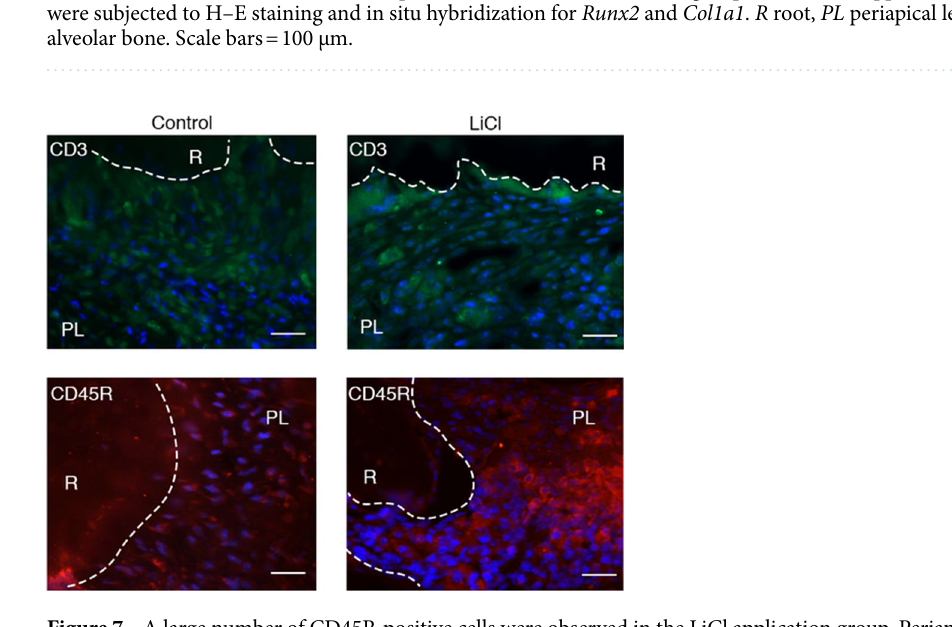
Figure 7. A large number of CD45R-positive cells were observed in the LiCl application group. Periapical lesion tissues of the control group and the LiCl application group were visualized by staining with Alexa 488 (CD3), Alexa 594 (CD45R), and DAPI. R root, PL periapical lesion. Scale bars = 50